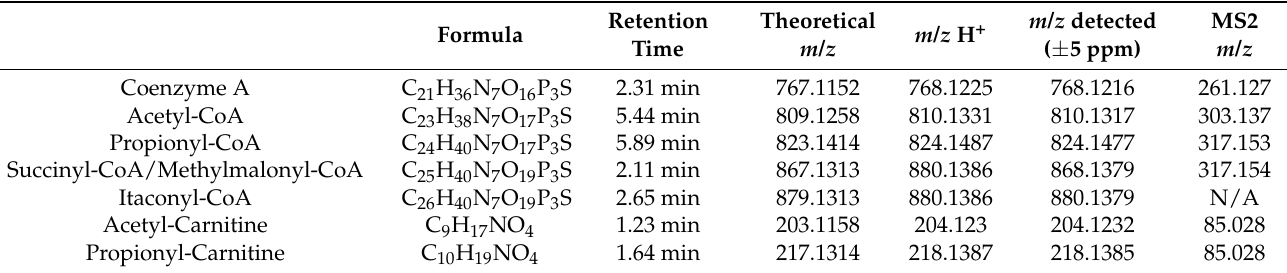
Table 1. Identification of CoA and carnitine species using Q Exactive